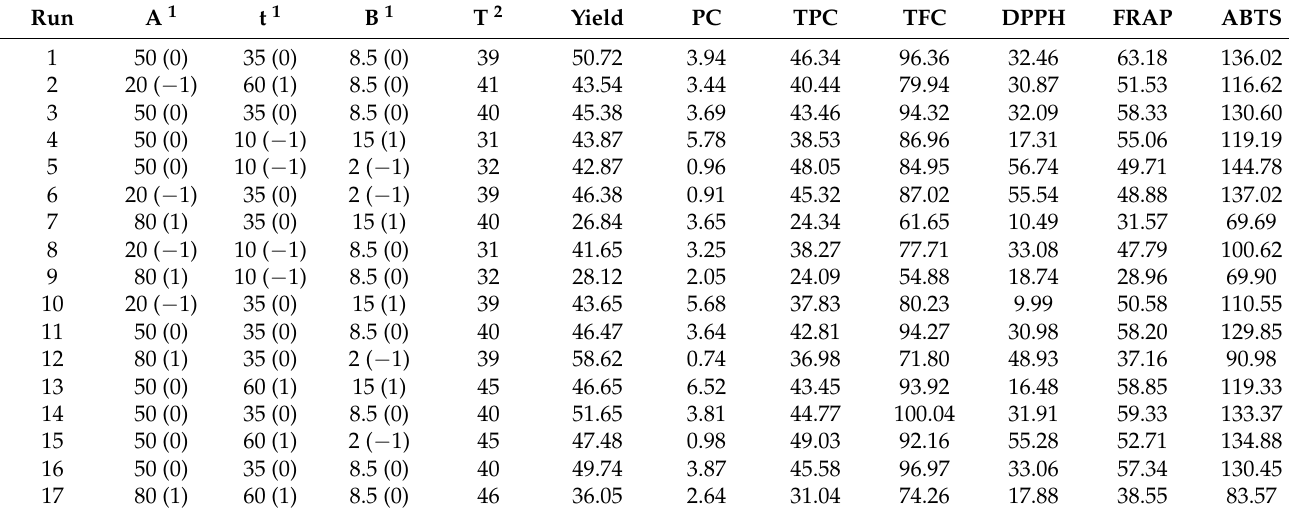
Table 3. Box–Behnken experimental design in terms of actual and coded factors applied to the bath-type ultrasound- assisted extraction of exhausted olive pomace (EOP) and experimental values of the response variables: yield (%), phenolic concentration (PC) (g gallic acid equivalents/L), total phenolic content (TPC) (mg gallic acid equivalents/g EOP), total flavonoid content (TFC) (mg rutin equivalents/g EOP), and antioxidant activity (DPPH, FRAP, and ABTS) (mg Trolox equivalents/g EOP).